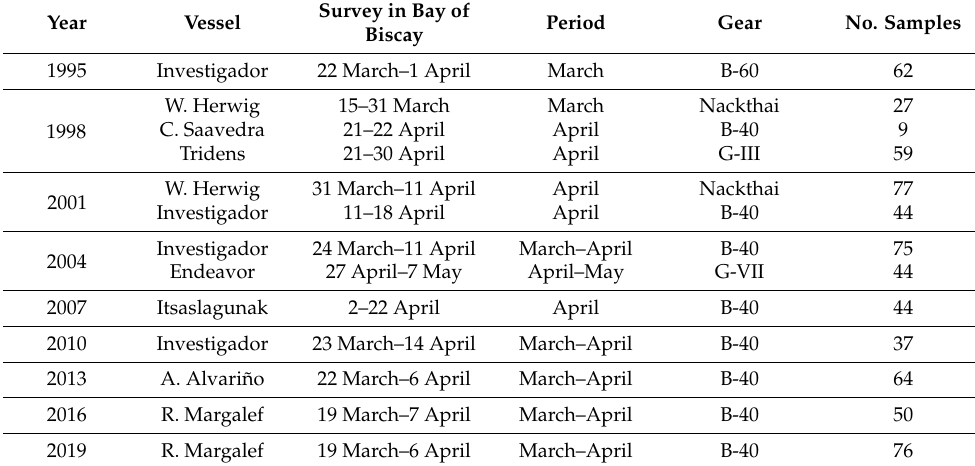
Table 1. The main characteristics of the surveys analyzed in this study. In all cases, the studied area corresponds to the Bay of Biscay. B-60 and B-40: Bongo plankton nets with 60 and 40 cm of mouth diameter, respectively. G-III-VII: Gulf plankton net, model III or